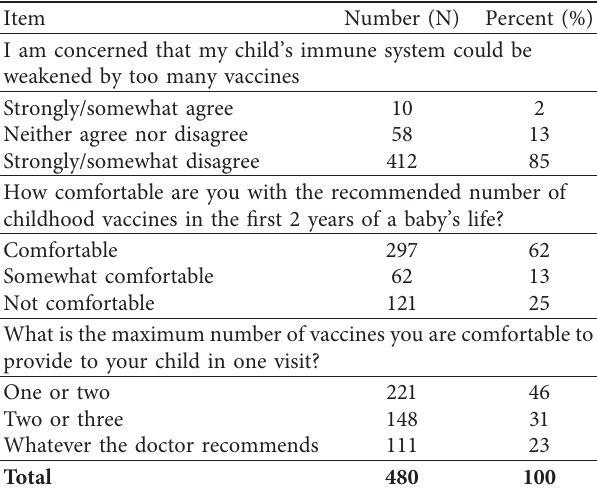
Table 3: The attitudes and behaviors regarding the vaccination number of parents surveyed.